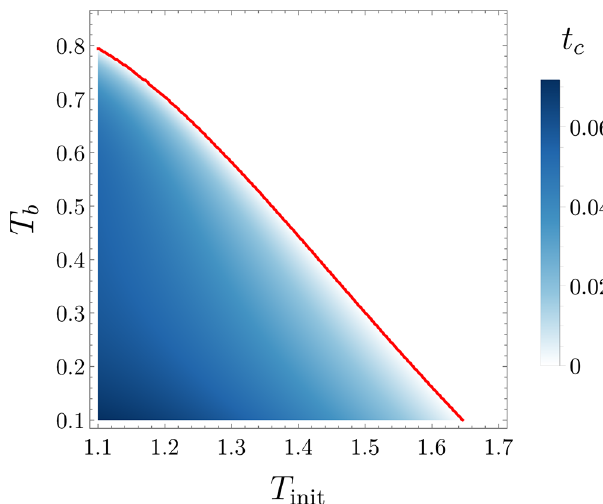
Fig. 3 Phase-transition time vs. initial temperature T init and fi nal temperature T b . Note that the initial conditions correspond to the disordered phase so T init > T c , and the bath temperatures correspond to the ordered phase so T b < T c . As for any bath temperature T b ⪅ 0.8, the phase- transition time t c ( T init , T b ) is a decreasing function of T init , the system exhibits the Mpemba effect. The red line separates the temperatures space ( T init , T b ) to two regions: on the left the Mpemba effect exists, whereas on the right it does